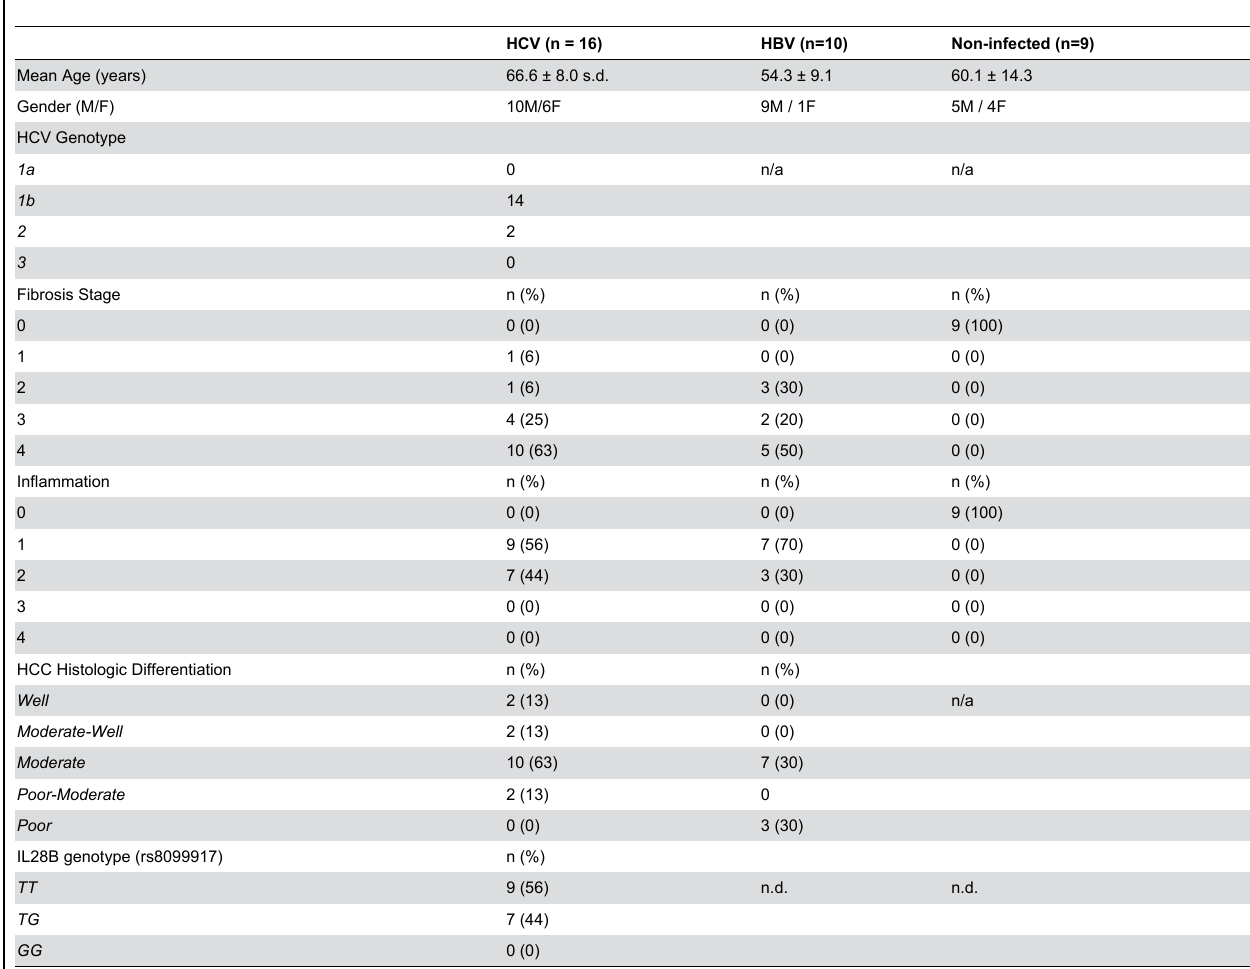
Table 1. Characteristics of Study